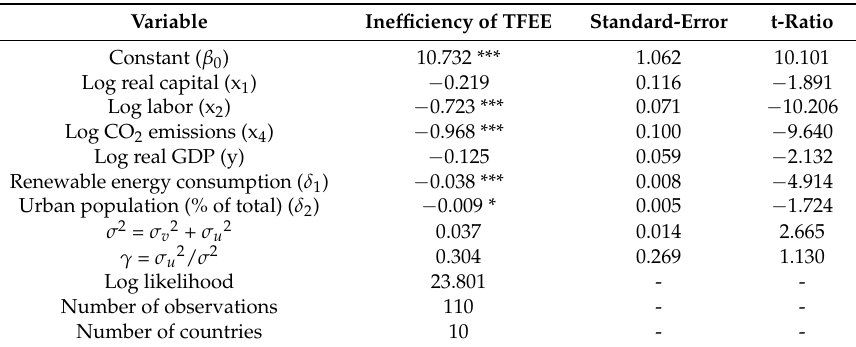
Table 2. Maximum likelihood estimation on the parameters.